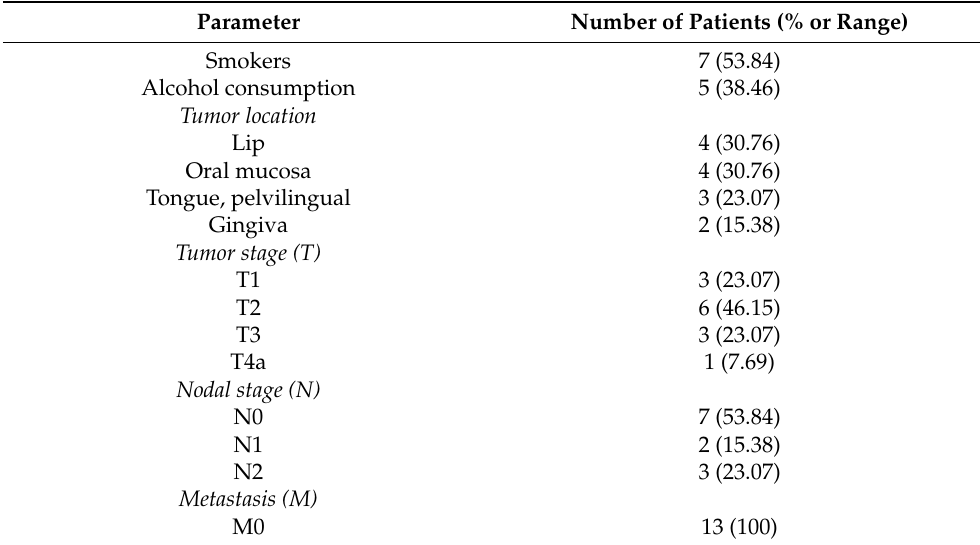
Table 2. Patient